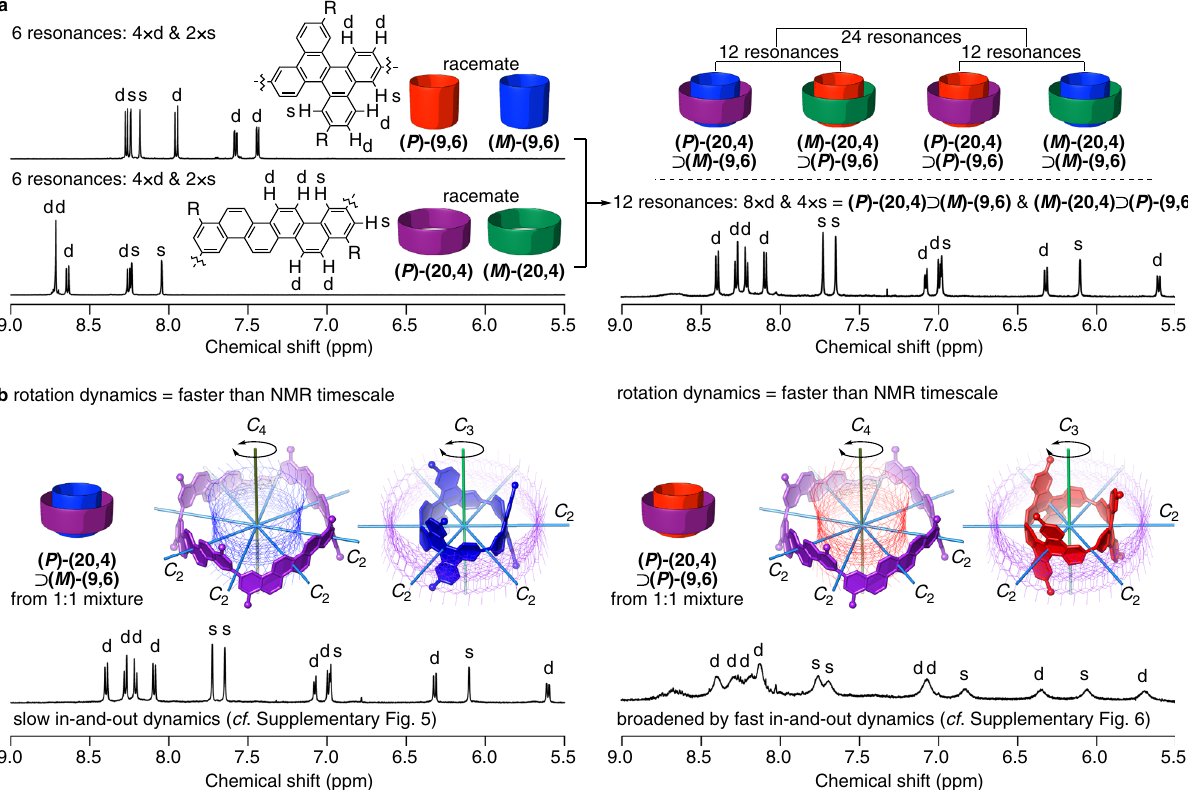
Fig. 4 Stereoselective spontaneous assembly of i-DWNT complexes. Spectra were recorded in CD 2 Cl 2 at 25 °C. a 1 H NMR spectra that demonstrates stereoselective assembly of a single set of i-DWNT diastereomers. Two sets of (9,6) and (20,4) racemates gave rise to the spectra of six aromatic resonances, and a 1:1 mixture of these two racemates resulted in 12 aromatic resonances. Minor 4 J couplings (<2 Hz) were found with some resonances, which were not included in designations of resonance shapes for clarity. b Two diastereomeric complexes were separately prepared to afford two different 1 H NMR spectra. The spectrum of heterohelical ( P )-(20,4) ⊃ ( M )-(9,6) was identical to that of the 1:1 mixture of racemates, and the spectrum of homohelical ( P )-(20,4) ⊃ ( P )-(9,6) con fi rmed the absence of these resonances in the spectrum of the racemate mixture. See also Supplementary Figs. 5 and